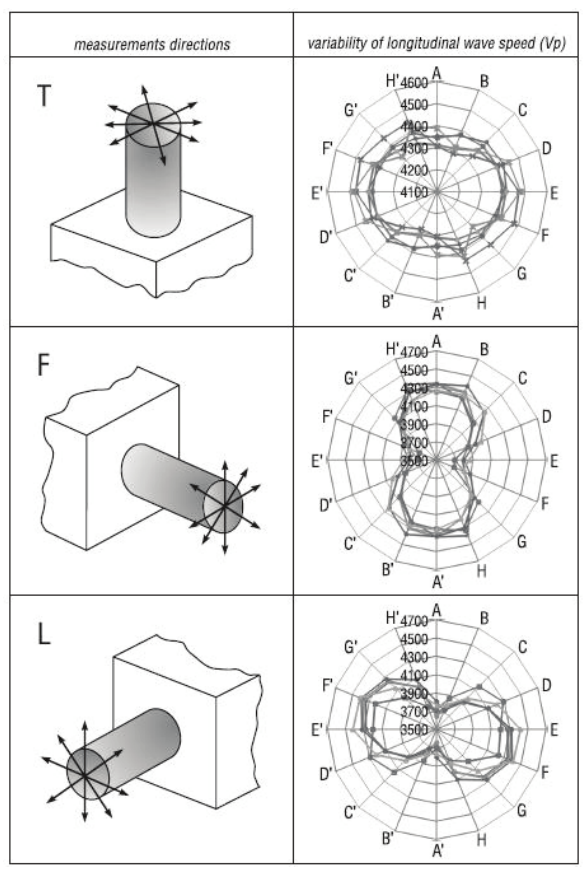
Fig. 5. Variability of longitudinal wave speed ( V p ) analysed in relation to the accepted research